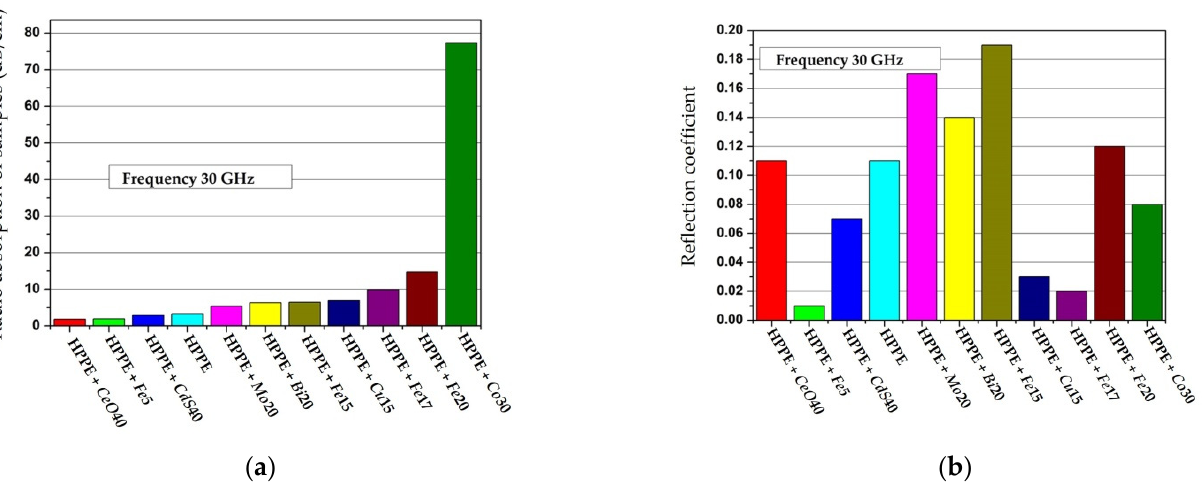
Figure 32. ( a ) Radio absorption and ( b ) reflection coefficients of composite materials based on metal- containing nanoparticles. metal-containing nanoparticles.